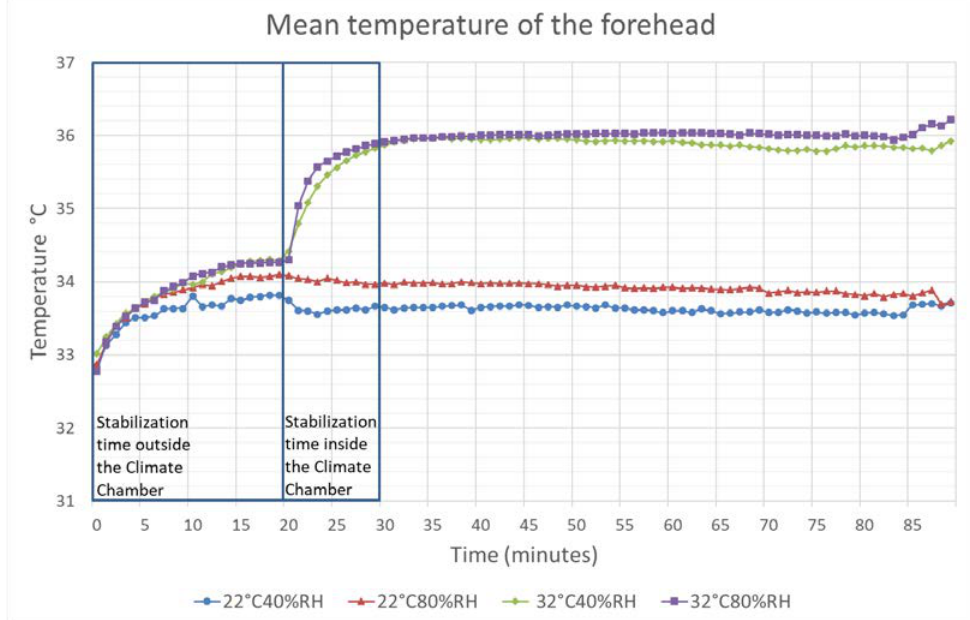
Figure 3. Forehead mean temperature in different environmental conditions